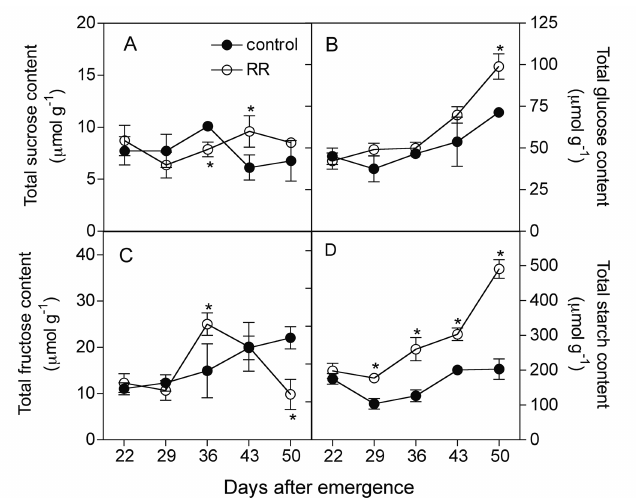
Fig. 5 - Starch content in the different plant organs measured at week- ly intervals from day 22 to the end of the experiment in both control and root-restricted (RR) plants: leaf (A), stem (B) and roots (C). * indicates significantly different values for P≤0.05 (n=5), when means were separated by Duncan’s